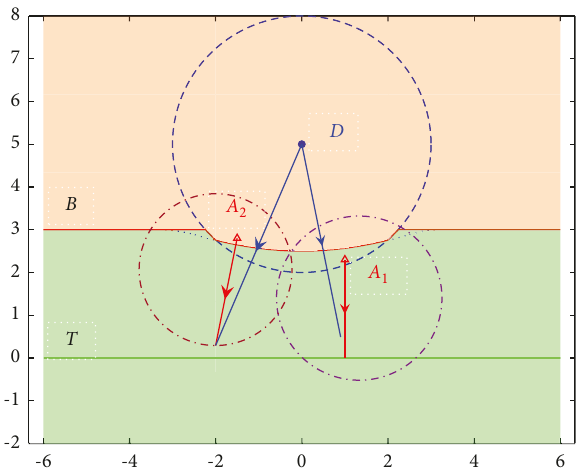
Figure 17: The numerical simulation of the barrier related to equation (68).